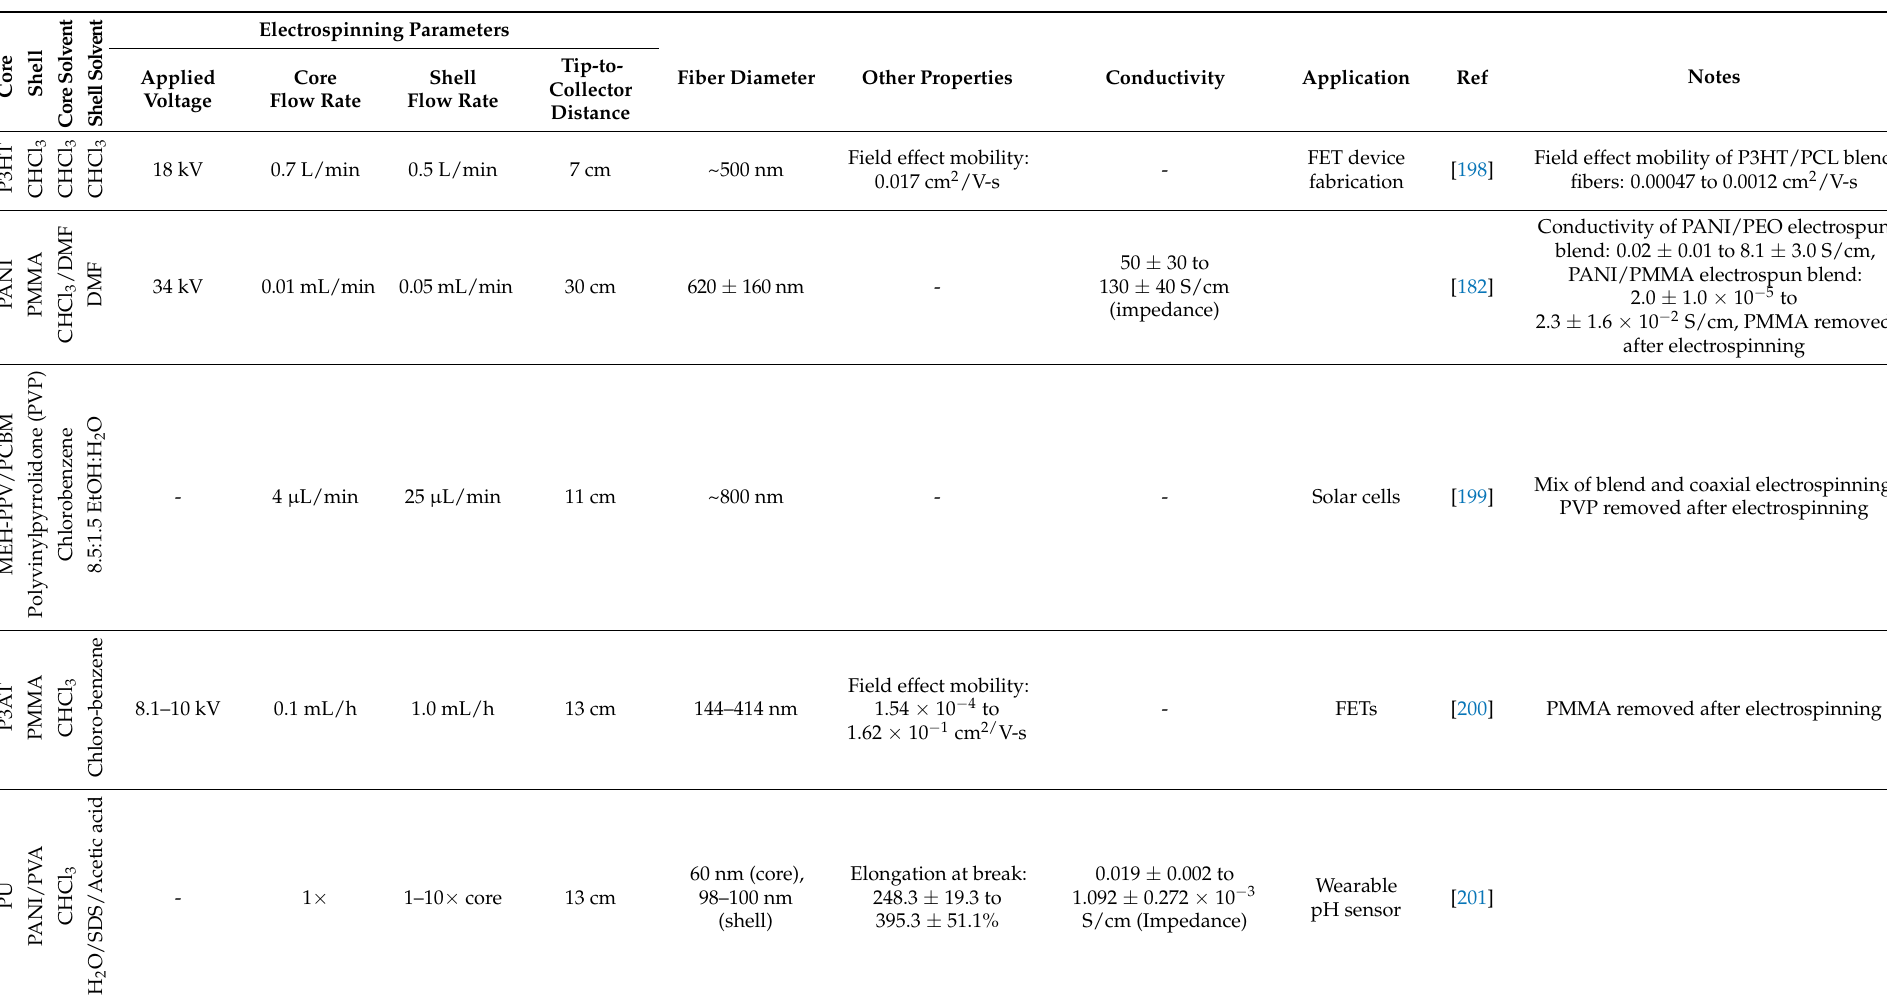
Table 2. Coaxially electrospun CPs discussed in the